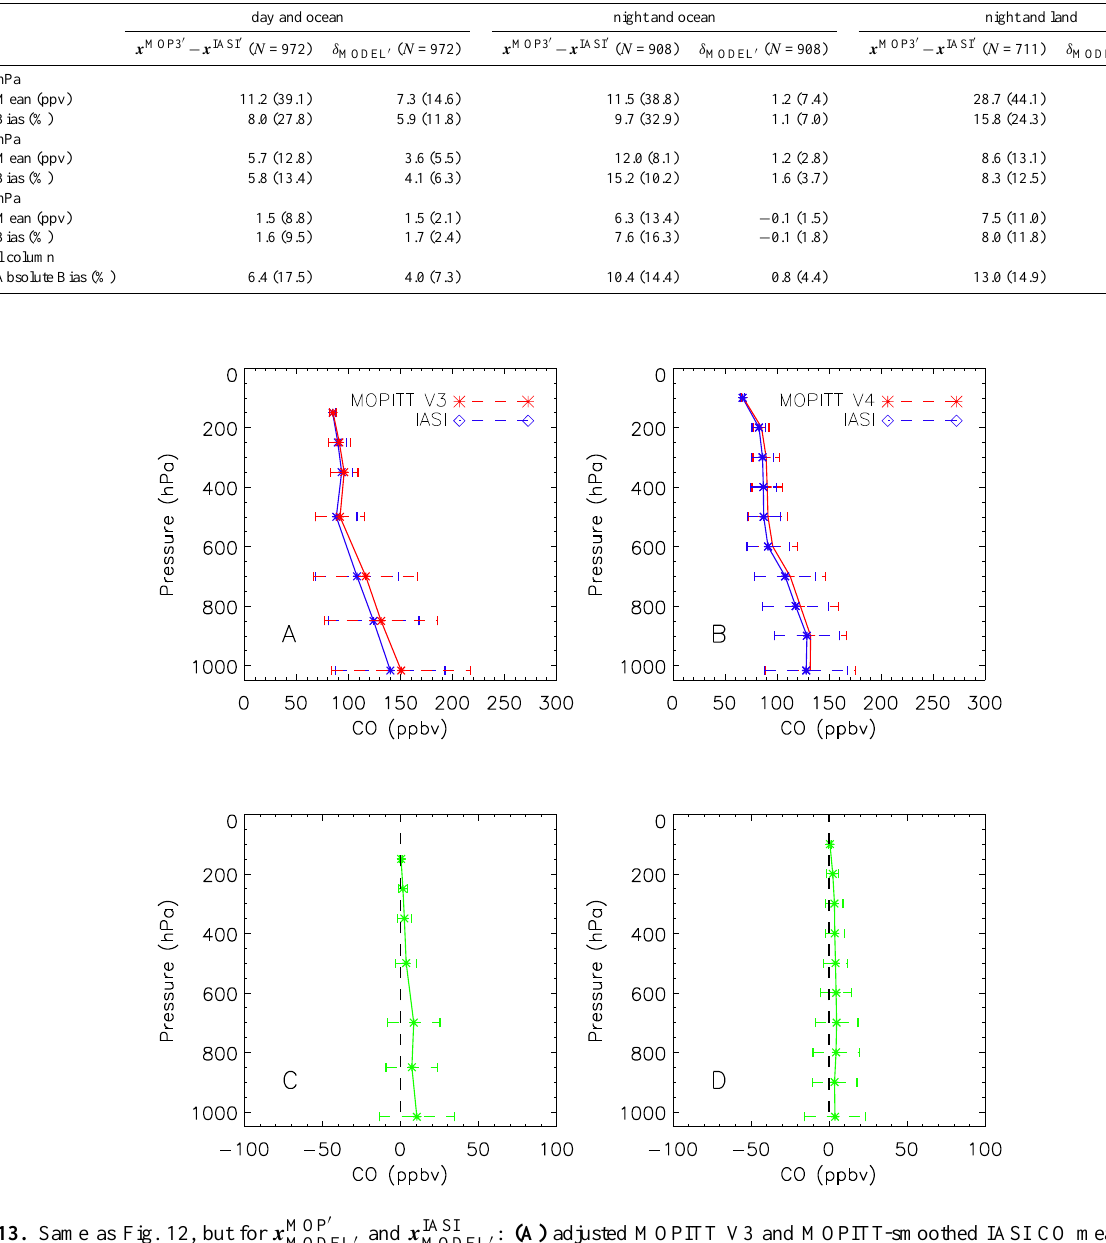
Table 3. δ x BIAS for IASI and MOPITT V3 CO retrievals for different scenarios.